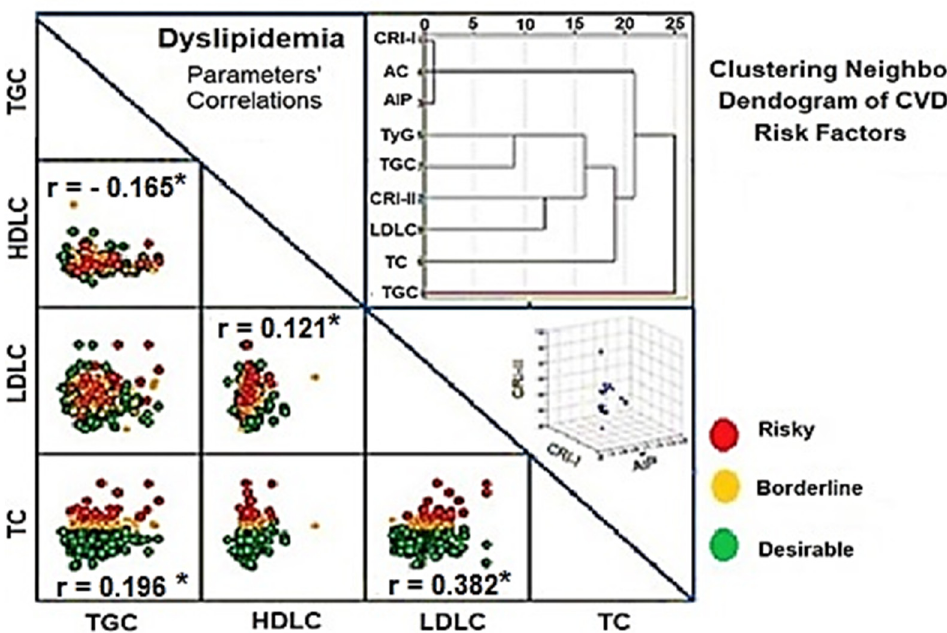
Figure 3. Pearson correlations (r) of lipid profiles: TC, TGC, HDLC, and LDLC as the dyslipidemic parameters, the main predisposing factor of CVD. The hierarchical dendrogram showed a clustering analysis of the cross-linkages between the nearest neighbor cardiometabolic risk factors and lipid profiles. Risky, borderline, and desirable levels of hypercholesterolemia, hypertriglyceridemia, HDLC, and LDLC, are shown in Table 1. Asterisk (*) denotes a significant difference at p < 0.05.